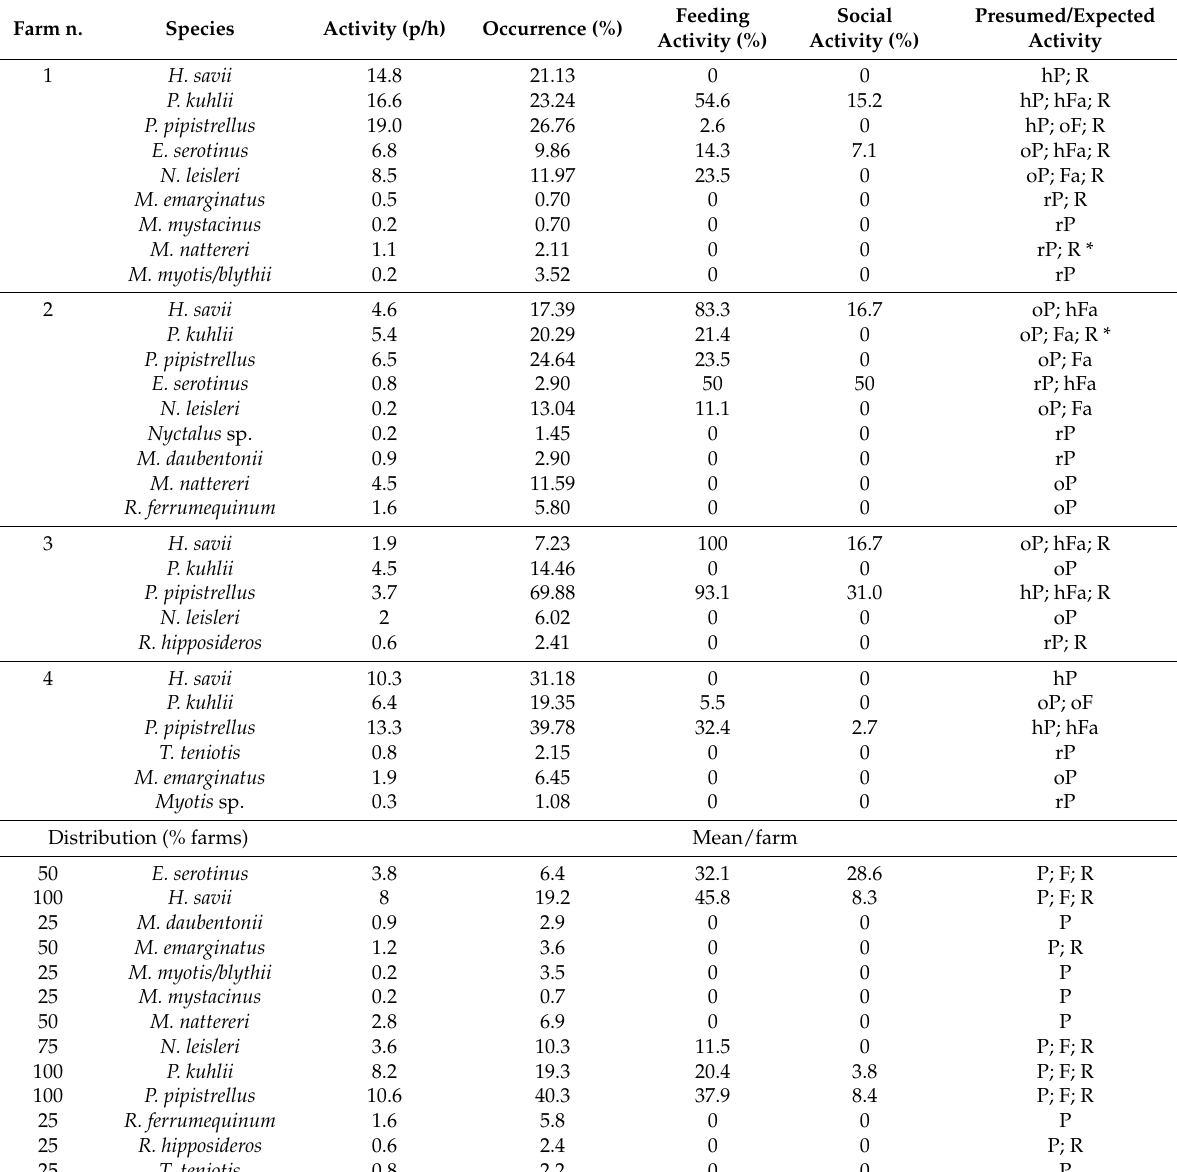
Table 2. Results of bioacoustics analysis per farm and for each bat species. Acronyms used to characterize the activity of bats: P: passage, scored as rare (rP), occasional (oP) or habitual (hP); F: foraging, score as occasional foraging (oF), foraging area (Fa) or habitual foraging area (hFa); R: roost, flagged as * if confirmed during inspection. See supplementary methods for the assignation of categories. Farm